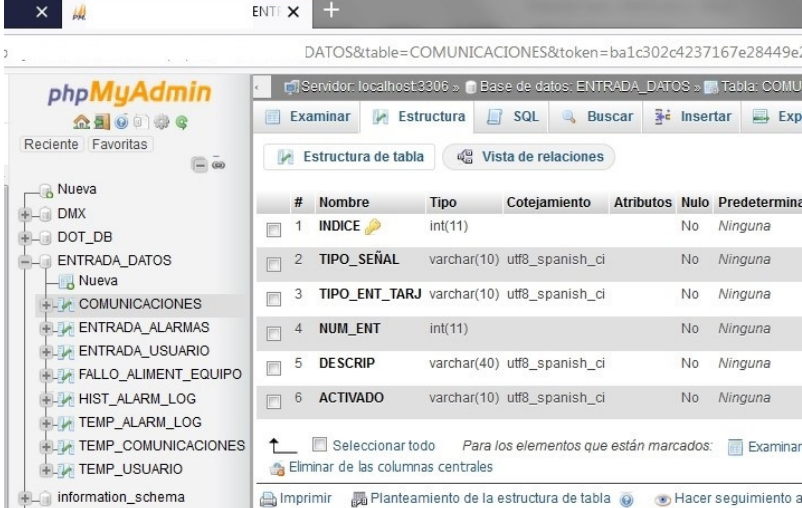
Figure 12. Platform communication table structure.